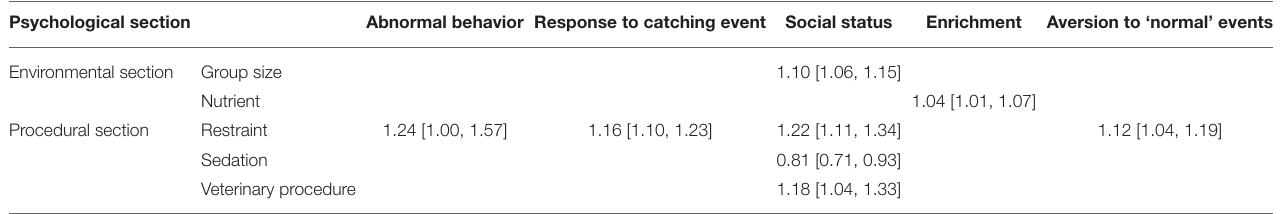
TABLE 7 | Estimates and 95% confidence intervals of odds ratio of psychological AWAG factors or any of environmental and procedural factors ( α =